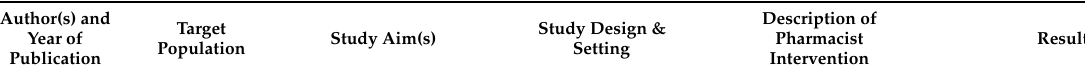
Table 6. Secondary prevention interventions for emergency and acute